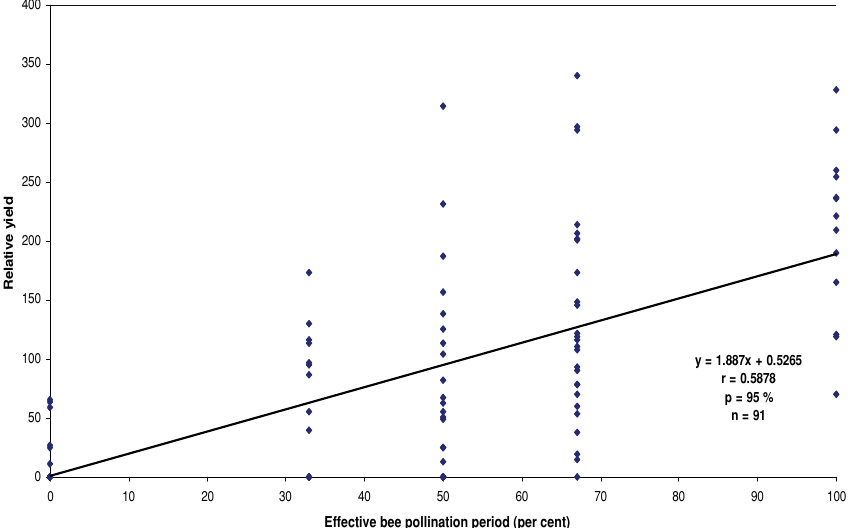
y= 1.887x + 0.5265 r= 0.5878 p= 95 % n=